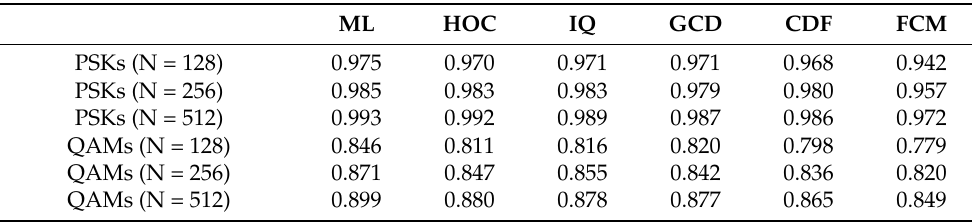
Table 3. Average probability of correct classification of different features under Gaussian channel at N = 128, 256, and 512.